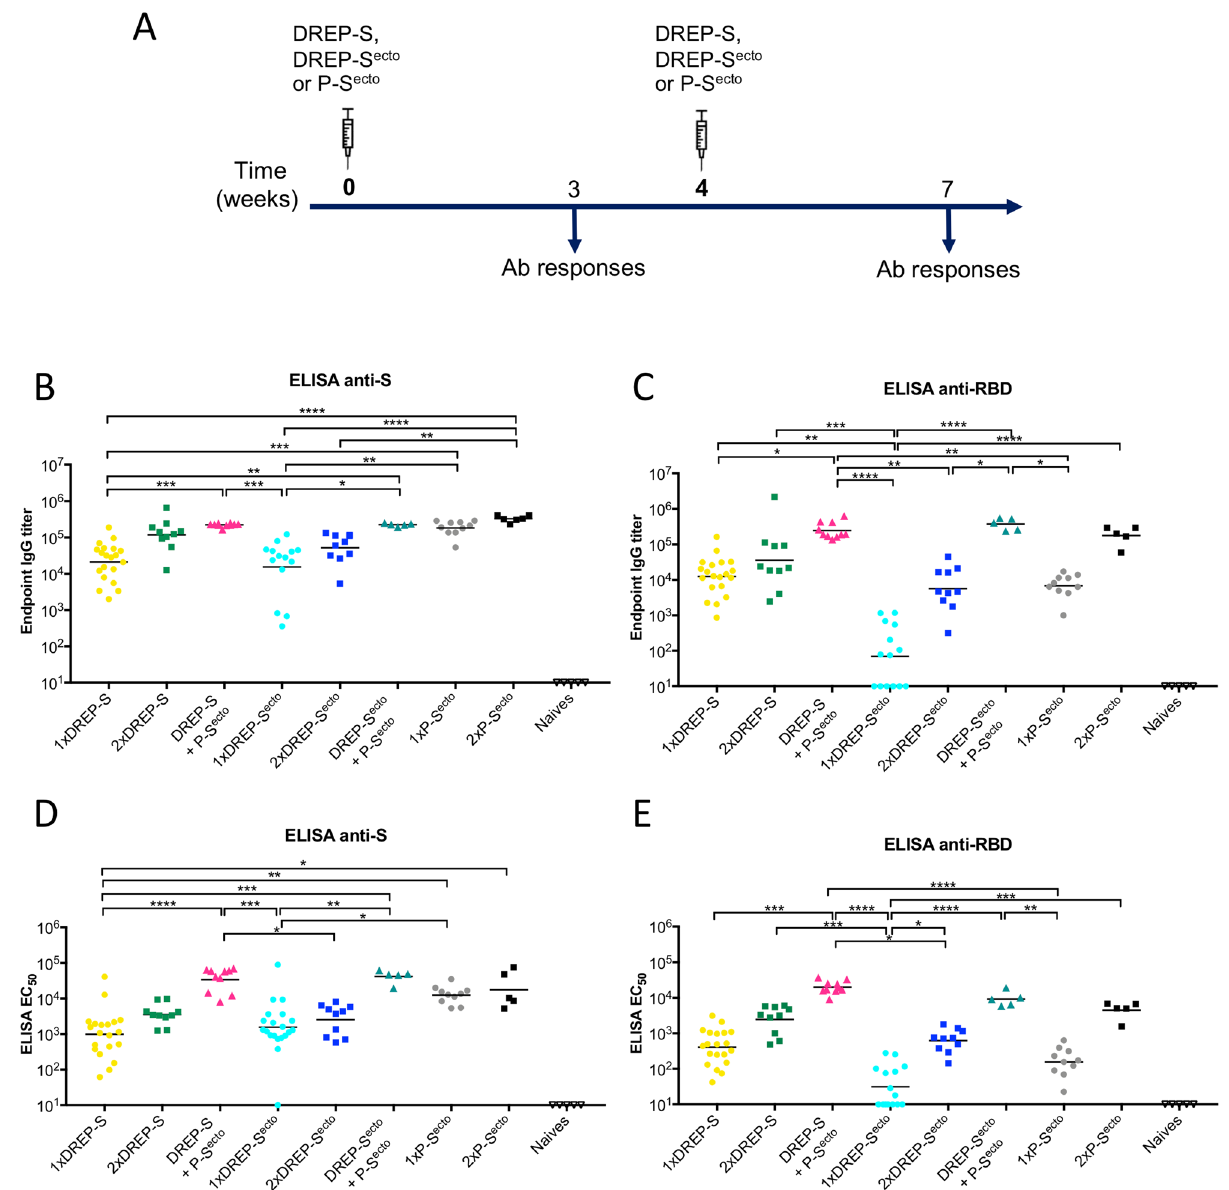
Figure 2. Anti-SARS-CoV-2 IgG antibody responses. ( A ) Schematic representation of the experiment schedule. C57BL/6 J mice (n = 5–20/group) were immunized once or twice with 10 μg of either DREP-S, DREP-S ecto or S ecto protein (P-S ecto ) and blood samples were collected three weeks after each immunization. Individual serum samples were assayed by ELISA using plates coated with SARS-CoV-2 spike (S) or receptor binding domain (RBD) antigens ( B , D and C , E , respectively). The results are presented either as endpoint antibody titers ( B , C ) or EC 50 values ( D , E ). Statistical analysis was performed using Kruskal Wallis test followed by Dunn’s test for multiple comparisons, * p < 0.05; ** p < 0.01; *** p < 0.001, **** p < 0.0001. Comparisons that were non-significant are not